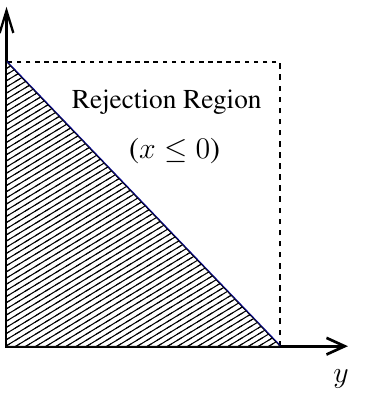
Figure 2. Avoiding rejection. As explained in the text, from the original integration region, ( y, z ) ∈ [0 , 1] × [0 , 1] , only the one below the line z = 1 − y contributes to φ in this lower triangle, the density, φ with by reweighting the integral.